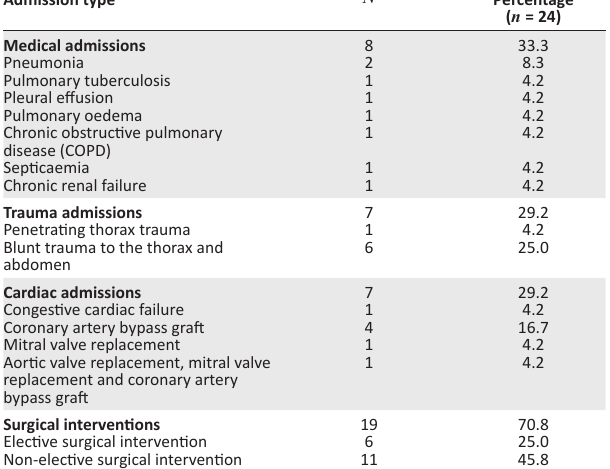
(42.4 ± 31.3, 95 % CI: -63.4 to -21.4, p = 0.00) and ankle dorsiflexion (29.9 ± 36.9, 95 % CI: -54.7 to -5.1, p = 0.02), left- sided hip abduction (36.4 ± 45.2, 95 % CI: -66.7 to -6, p = 0.02), knee flexion (40 ± 43.3, 95 % CI: -69 to -10.9, p = 0.01) and ankle dorsiflexion (43.3 ± 48.1, 95 % CI: -75.7 to -11, p = 0.03). The median distance walked on the 6MWT was 425 m (IQR 332.5–517.5) at 1 month and 490 m (IQR 400–570) at 6 months.